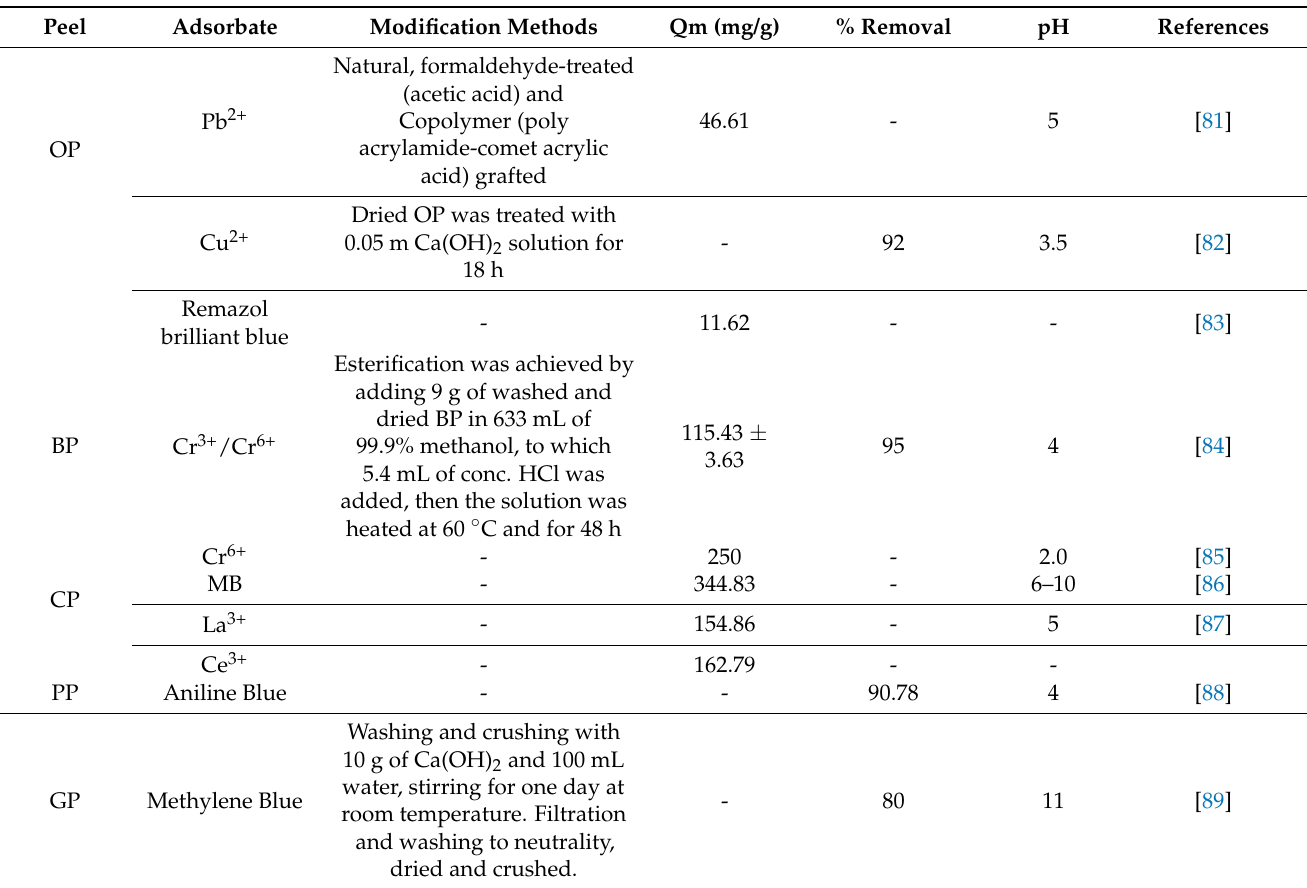
Batch adsorption studies for organic/inorganic removal using FPW as